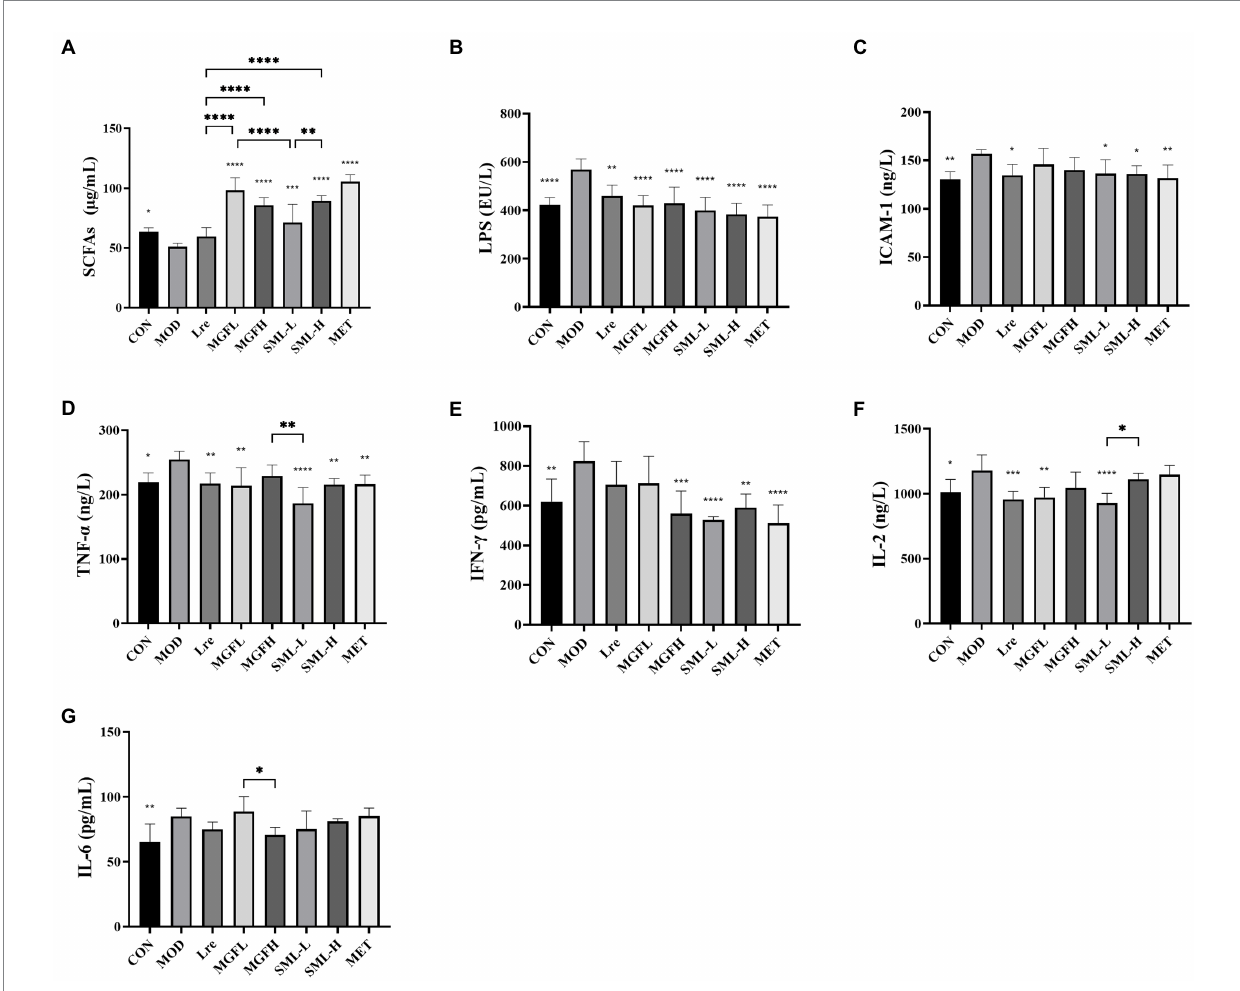
FIGURE 2 Serum biochemical parameters in T2DM rats. (A–G) represented the contents of SCFAs, LPS, ICAM-1, TNF- α , IFN- γ , IL-2, and IL-6. * p < 0.05, ** p < 0.01, *** p < 0.001, **** p < 0.0001 compared with the MOD, and the SML and its components were